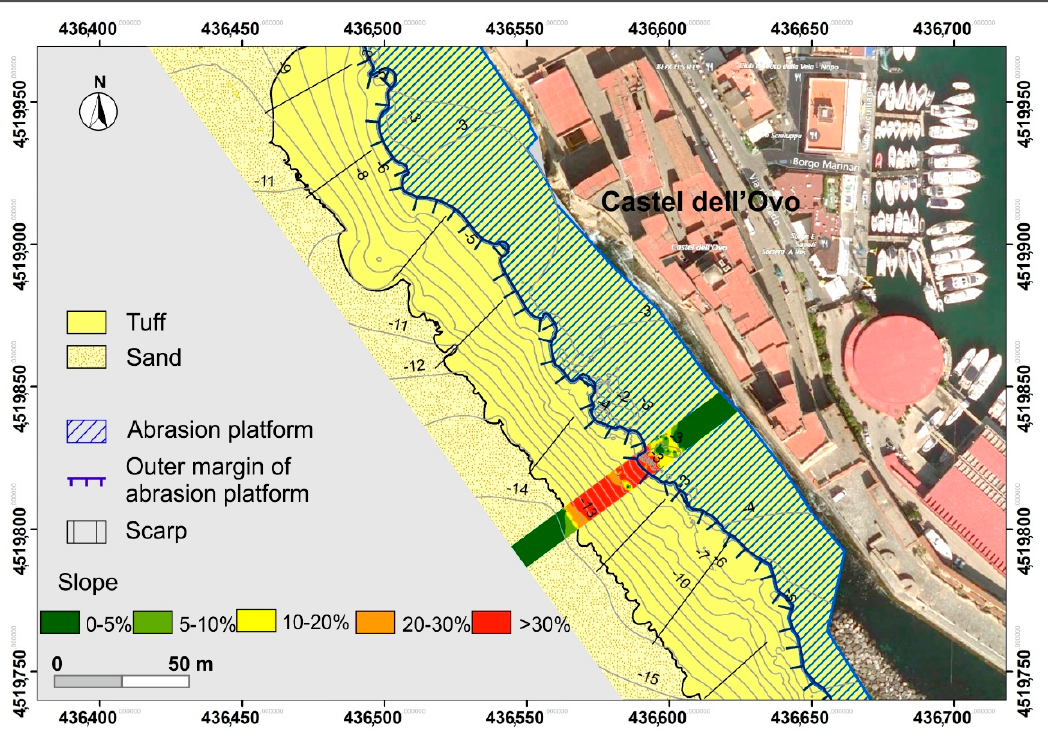
Figure 10. Geological and geomorphological map of the study area.